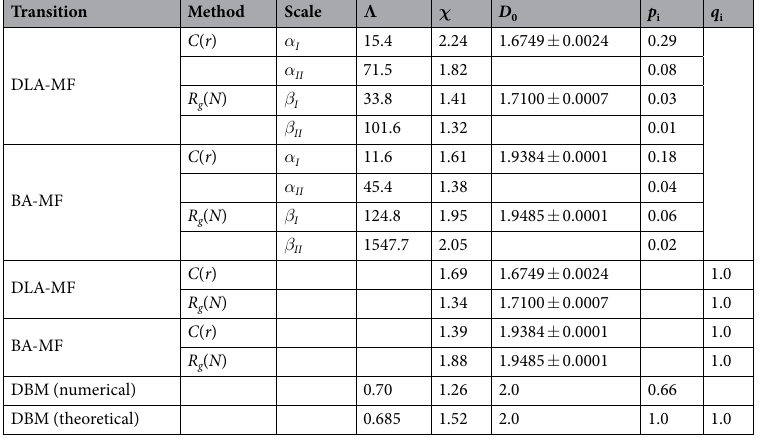
Transition Method Scale Λ χ D 0